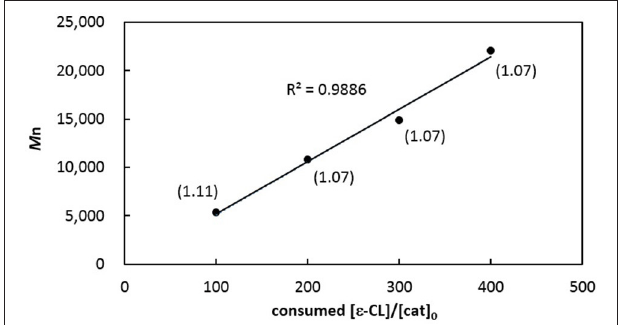
FIGURE 5 | Linear plot of corrected M n of PCLs vs. monomers consumed to [ 3a ]Al(OCH 2 Ph) ratios (entries 9 and 12–14 in Table 1 ). Numbers shown in parentheses indicate their corresponding PDIs.